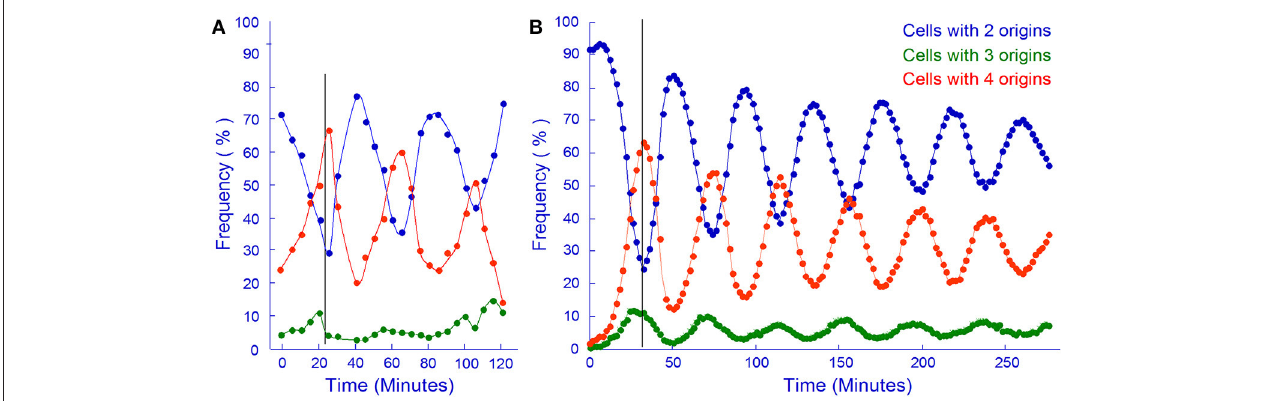
FIGURE 11 | In vivo and in silico synchronized cultures. (A) Samples from a synchronous culture obtained using the baby cell machine were incubated with rifampicin and the frequency of cells containing different numbers of origins were determined by flow cytometry (redrawn from Figure 4A in Løbner-Olesen et al., 1994, Copyright, John Wiley and Sons). (B) Same as A but using computer simulation of the Initiator Titration Model to obtain baby cells. The cell size variation in this simulation had a CV of